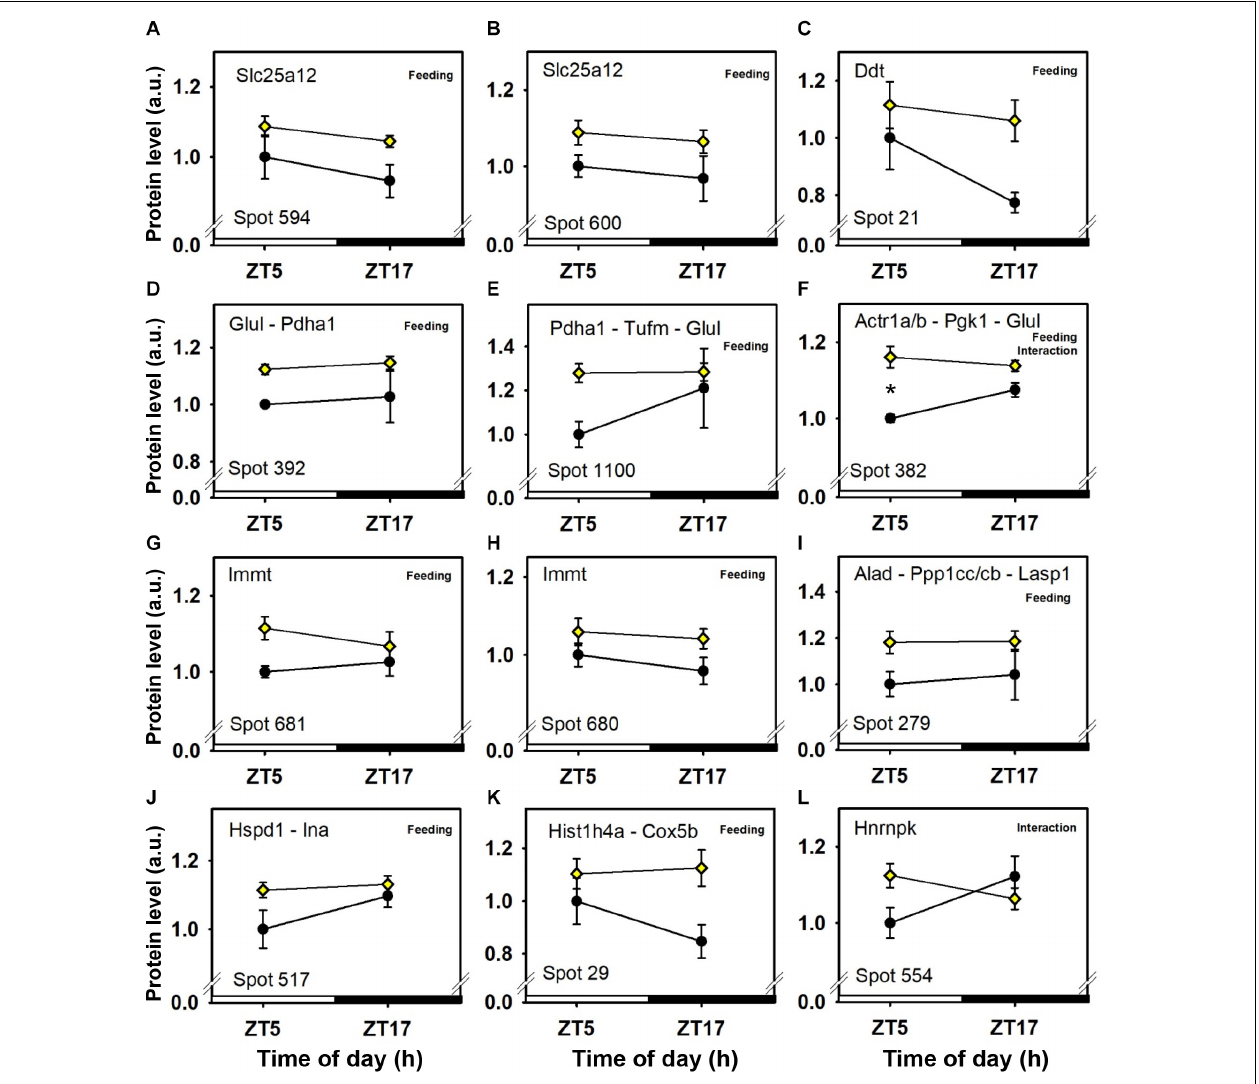
FIGURE 6 | Day–night expression of cerebellar proteins mostly affected by feeding (3/3). From analyses in control mice fed ad libitum (closed circles) and mice exposed to daytime restricted feeding (yellow diamonds), “Feeding” and “Interaction” indicate significant ( P < 0.05) main effects of feeding conditions and time-of-day × feeding interactions, respectively, as detected by two-way ANOVA (see section “Materials and Methods” for details). * P < 0.05 after post hoc Tukey comparison. Different part labels have been attributed to each differentially-expressed proteins; see details in the main